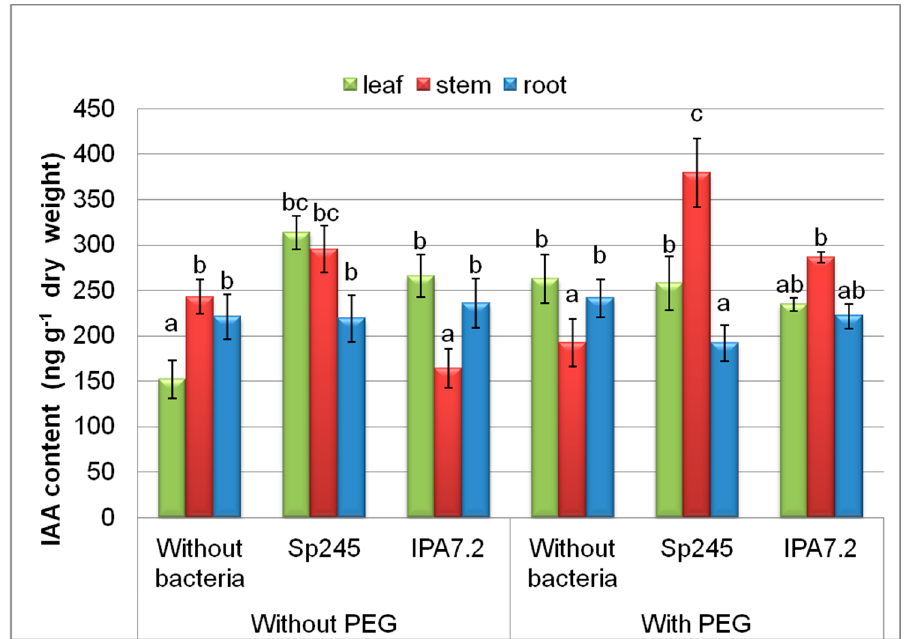
Figure 1. The effect of PEG and microplants inoculation with bacterial strains ( A. brasilense Sp245 and O. cytisi IPA7.2) on the content of IAA in organs of potato plants cultivated in vitro. Means ± SE ( n = 6) marked with similar Latin letters do not differ significantly according to the LSD-test ( p ≤ 0.05).